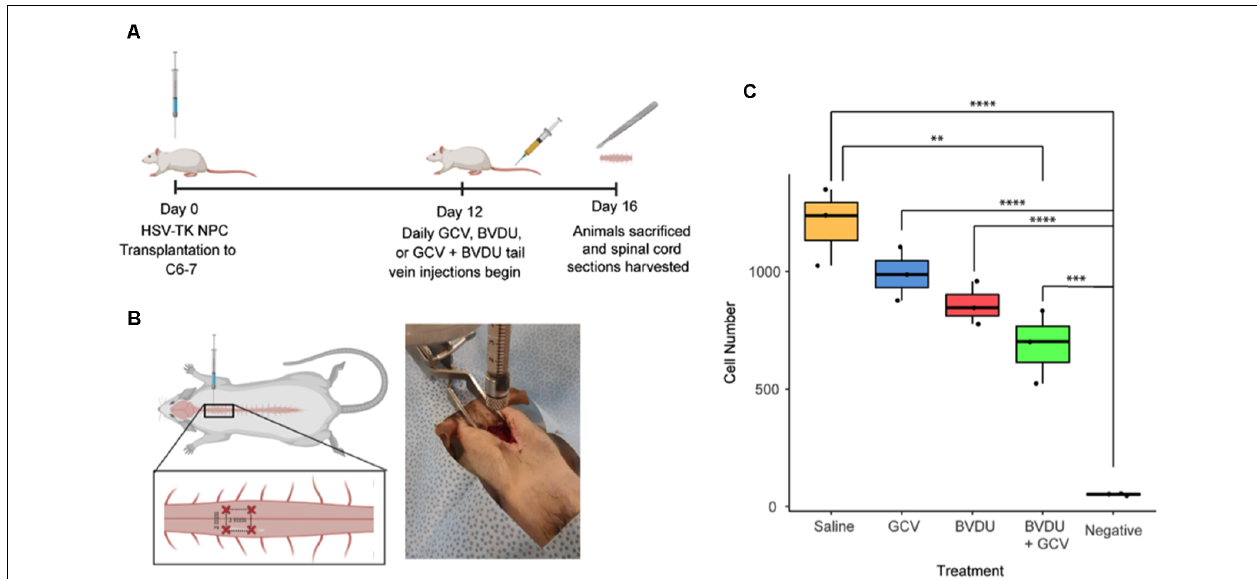
FIGURE 5 | Ablation efficiency of GCV and BVDU on transplanted HSV-TK + NPCs in a rat model. (A) HSV-TK expressing NPCs were transplanted into a rat model of spinal cord injury, and tail vein injections of 10 mg/kg of BVDU ( n = 3), 10 mg/kg of GCV ( n = 3), or 5 mg/kg of both BVDU and GCV ( n = 3) were given every day for 4 days at 12-days post-transplant. (B) Rats received four injections of NPC transplants at the C6–7 laminae of the cord, two injections on each side with ipsilateral injections being 2 mm apart from each other and 1 mm away from the center of the spinal cord. (C) Following the conclusion of injections, at 16 days post-transplant, cell survival was assessed by quantifying Alu element copy number from gDNA extracted from harvested spinal cord sections. Rats receiving combinatorial GCV and BVDU injections displayed a significant reduction in overall cell number as compared to the saline control ( P < 0.01). Individual administration of GCV or BVDU did not lead to a significant decrease in cell number. Data were standardized to gDNA concentration per 1 million rat cells. Diagrams (A) and (B) were created with biorender.com. ** P < 0.01, *** P < 0.001, **** P <